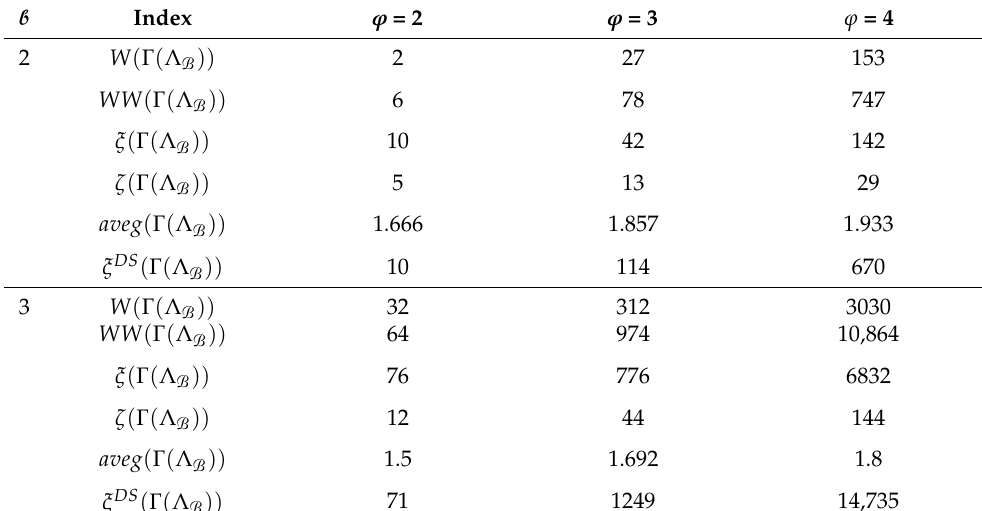
Figure 6. Γ ( Λ (cid:66) ) with ϕ = 4 and (cid:98) = 2. Table 1. Topological index of Γ ( Λ (cid:66) )